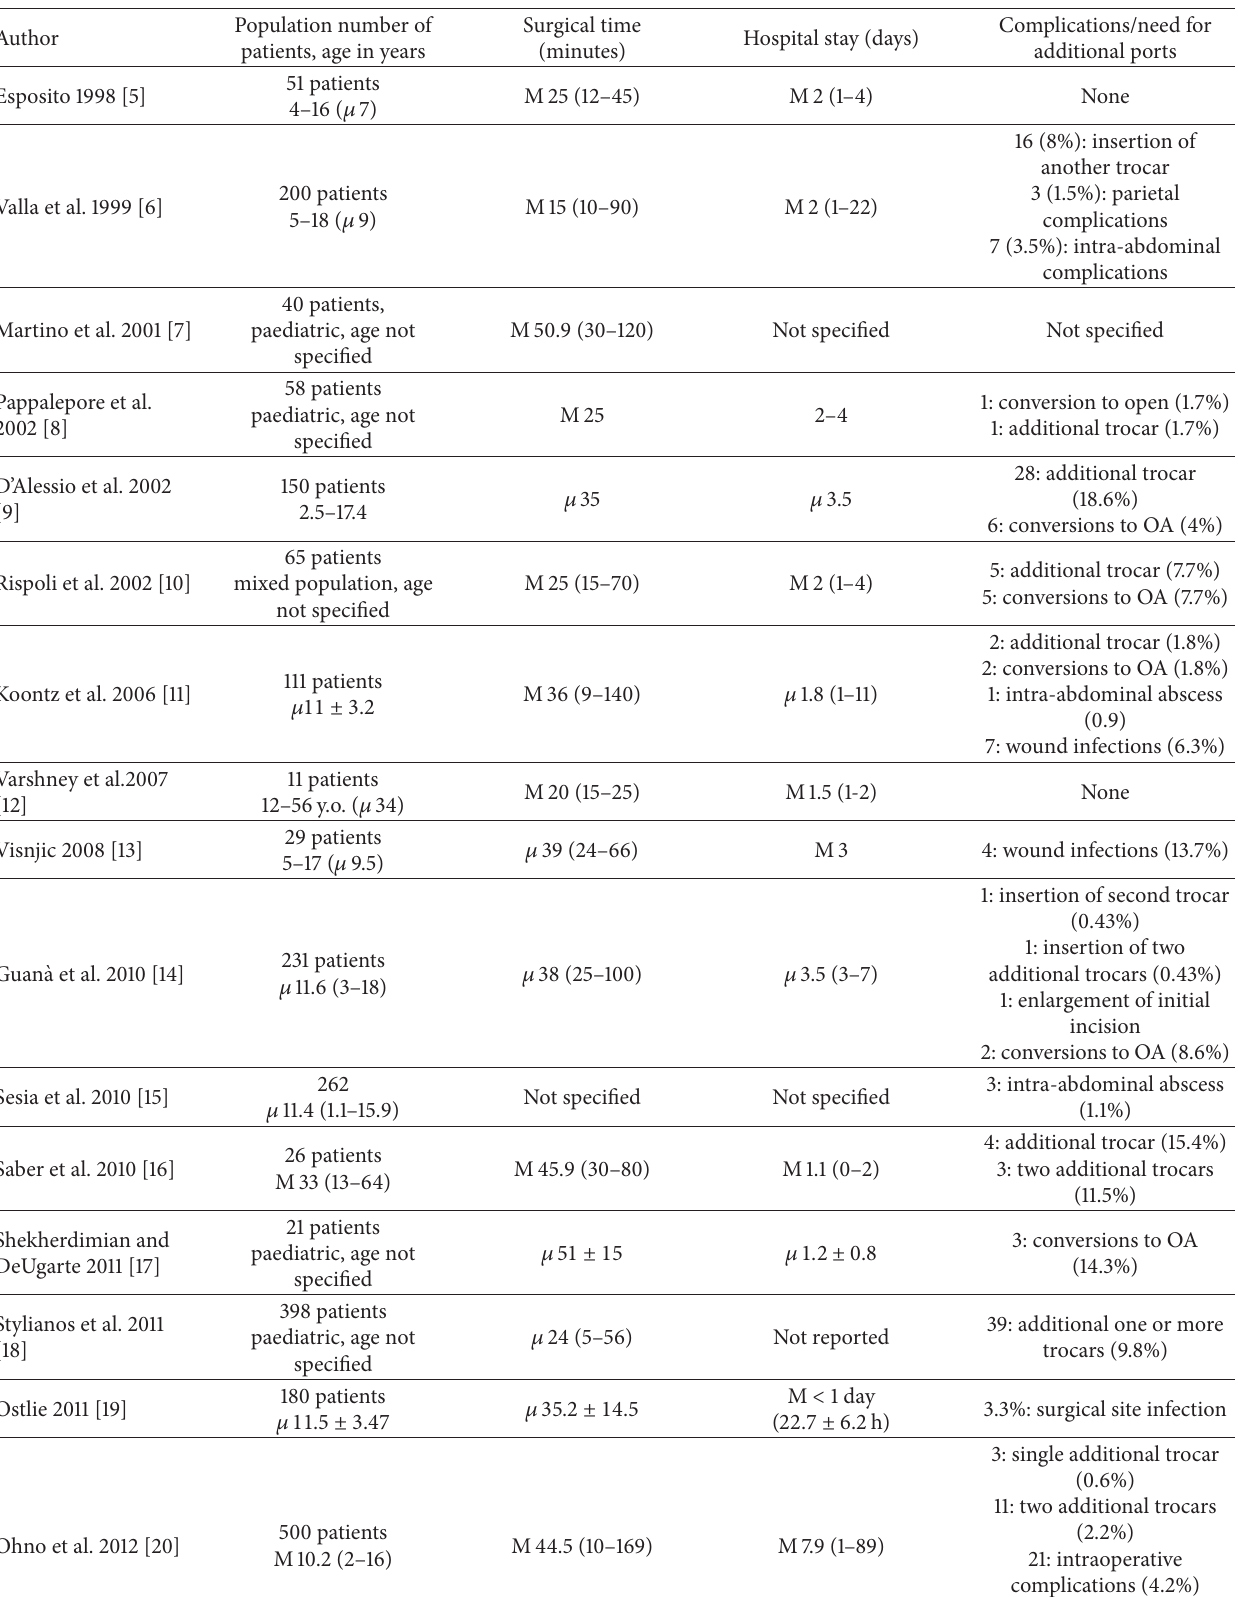
Table 2: Summary of the analysed literature including surgical time (in minutes), length of hospital stay (in days unless otherwise specified), and complications/need for additional